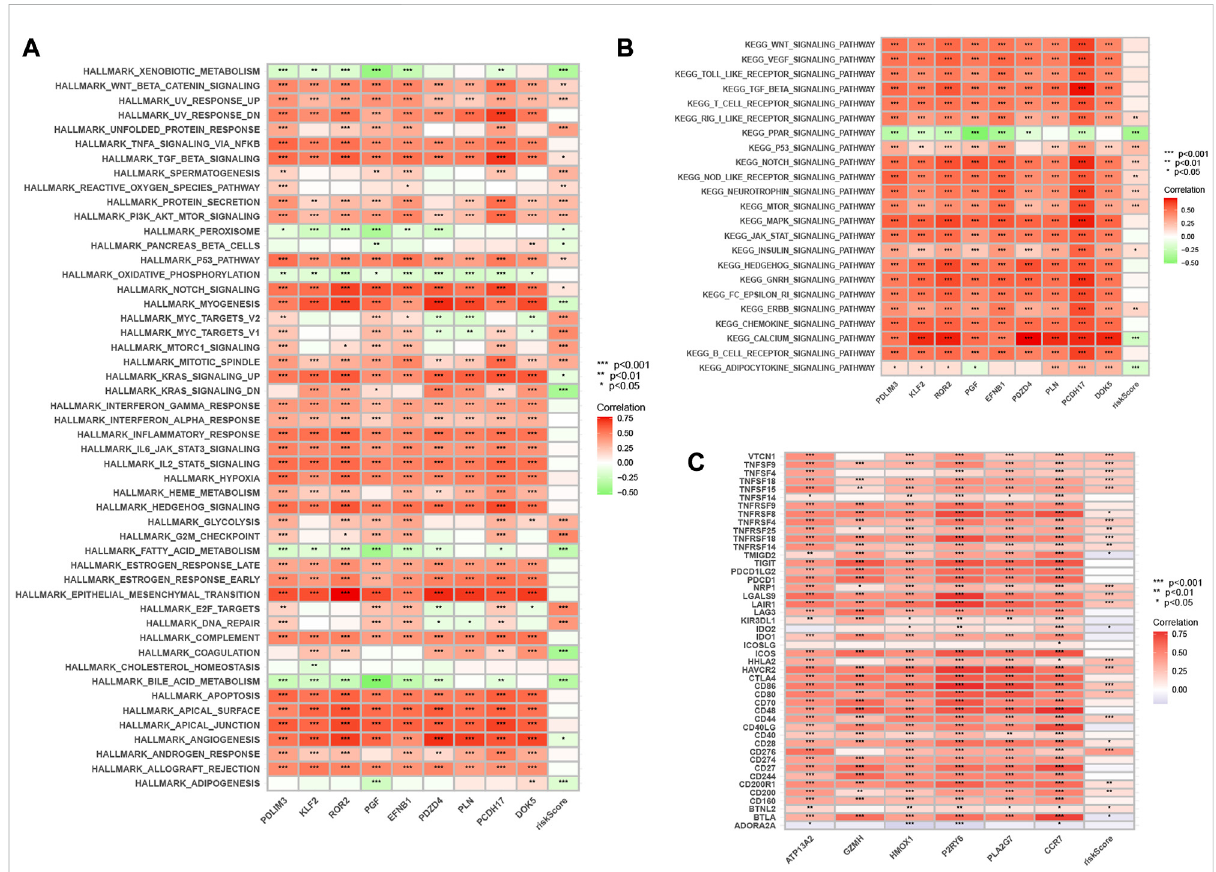
FIGURE 11 Enrichment pathways of GSVA. (A) Heatmap showing the correlation of representative pathway terms of Hallmark with risk score. (B) Heatmap showing the correlation of representative pathway terms of KEGG with risk score. Prediction of Immunotherapeutic Response. (C) Correlation of expression level of immune checkpoint blockade genes with risk